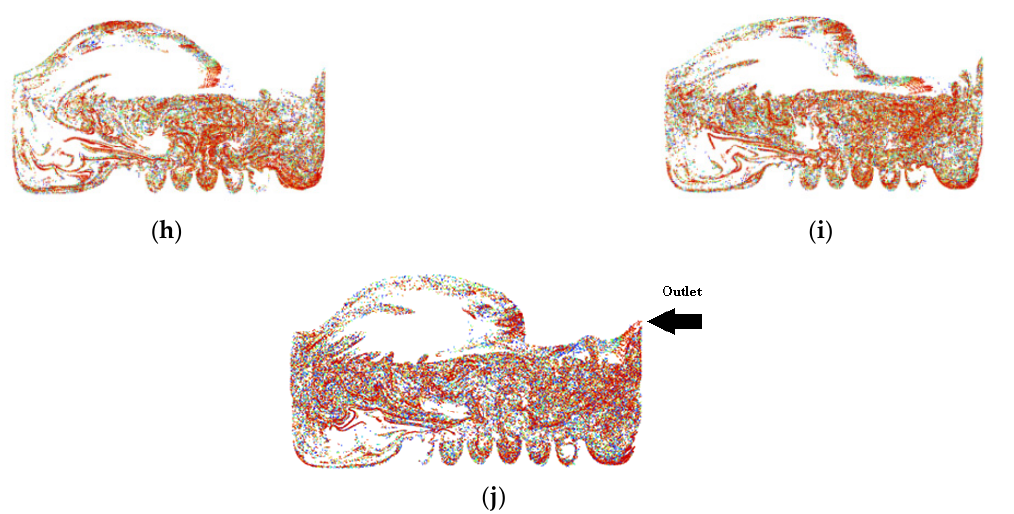
Figure 9. Particle tracking of Simulation 2: ( a ) 0.0 s; ( b ) 0.5 s; ( c ) 1.0 s; ( d ) 1.5 s; ( e ) 2.0 s; ( f ) 2.5 s; ( g ) 3.0 s; ( h ) 3.5 s; ( i ) 4.0 s; ( j ) 4.5 s.